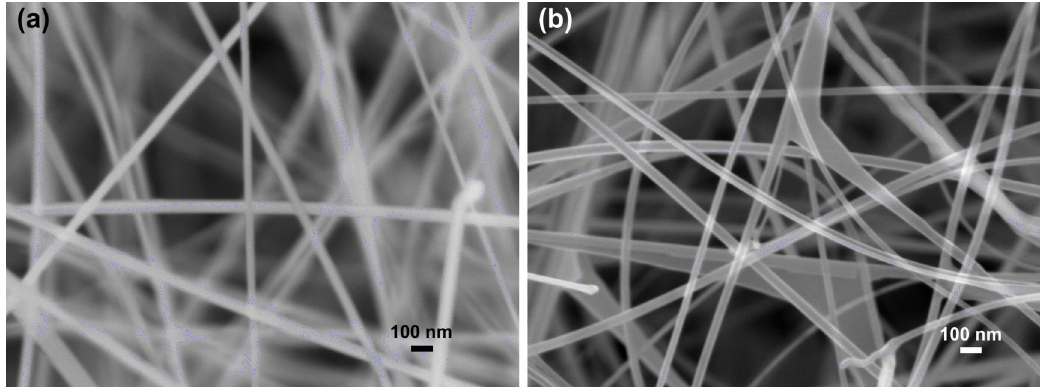
Figure 1. SEM images of the nanowires grown by CVD and used as gas sensors: ( a ) ZnO nanowires; ( b ) SnO 2 nanowires.